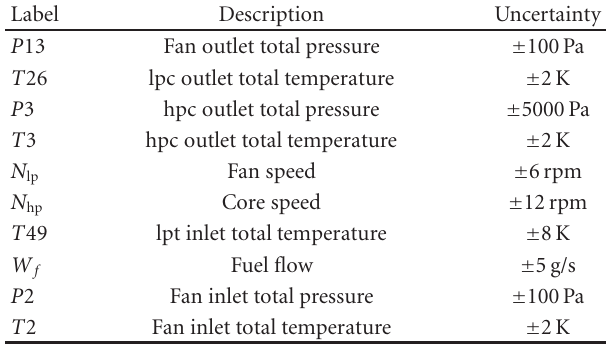
Table 1: Gas-path and operating condition instrumentation.